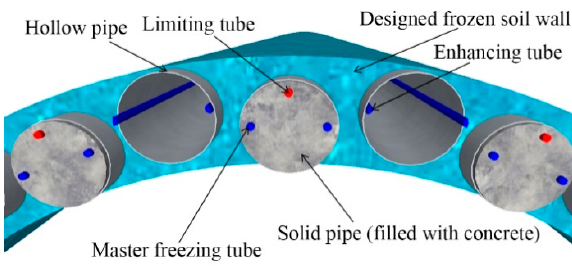
Figure 2. Schematic of the freezing scheme.